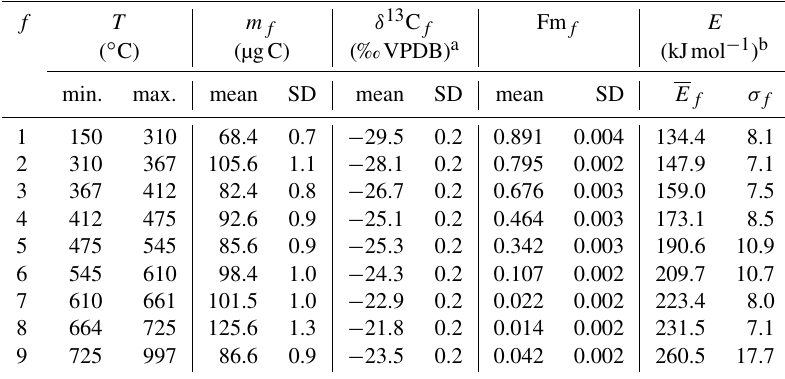
Table 2. Narayani POC RPO temperature ranges, carbon masses, δ 13 C, Fm, and E for each fraction, f . All masses and isotope values are blank corrected following Hemingway et al. (2017). See Eqs. (41)–(42) for E calculations.